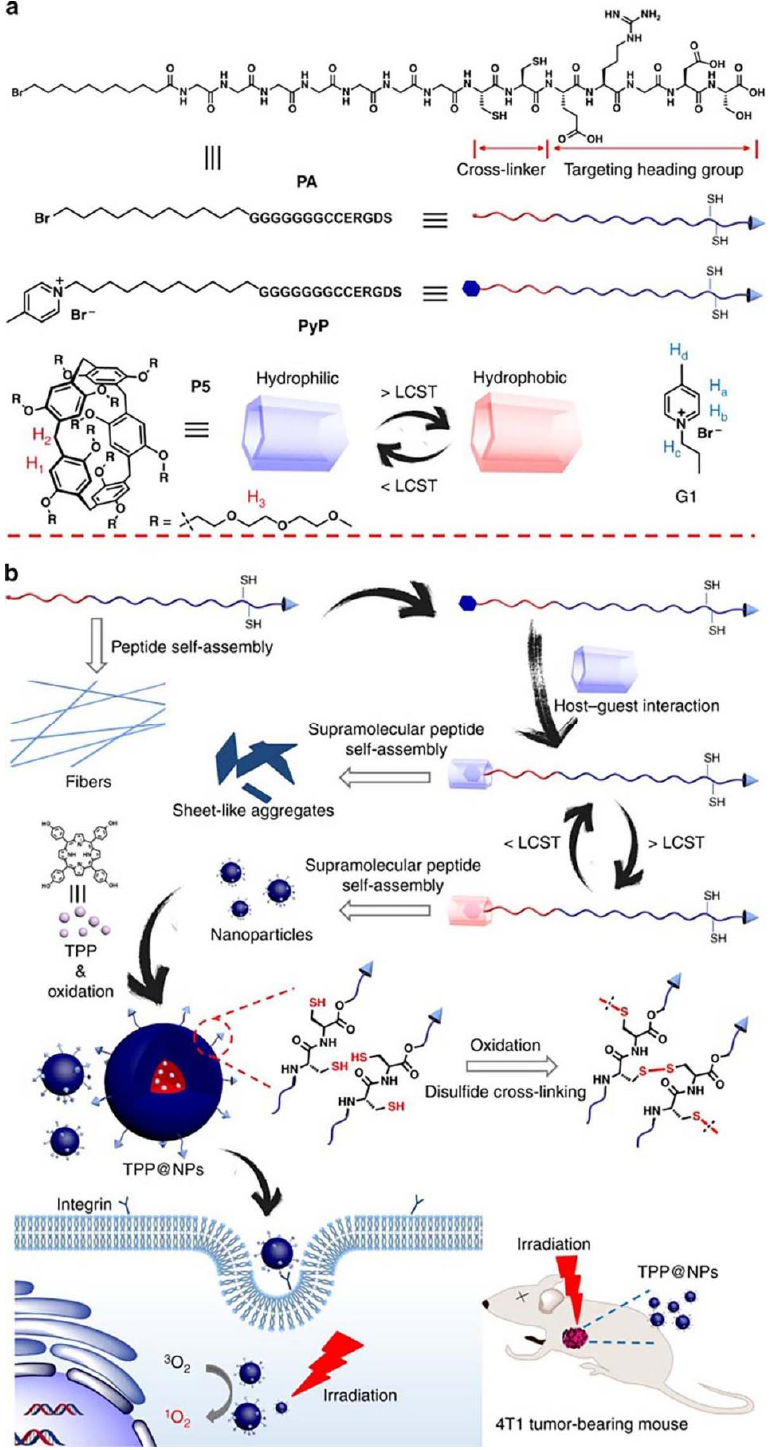
Figure 13. Peptide self-assemblies with multiple nanostructures in photodynamic therapy ( a ) Chem- ical structures and cartoon representations of PA, PyP, and P5. ( b ) Schematic illustrations of the programmable peptide self-assembly and PDT process. (reproduced with permission of Springer Nature from ref. [83]).